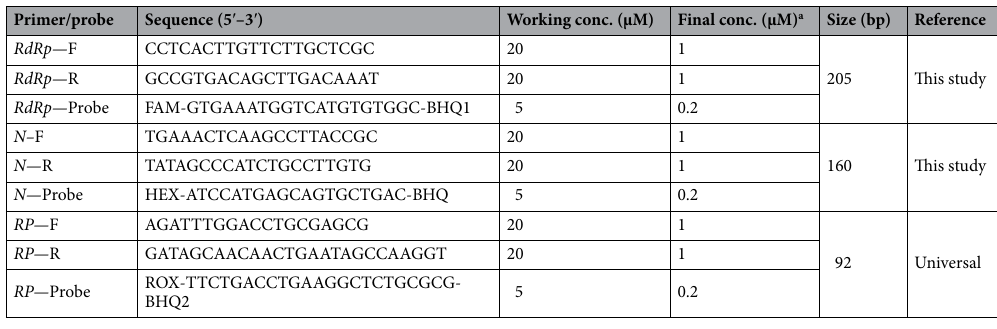
Table 1. The sequence and concentration of primer and probe sets used in PCR reactions. a Final concentration represents the concentration of each oligonucleotide in reaction mixture (20